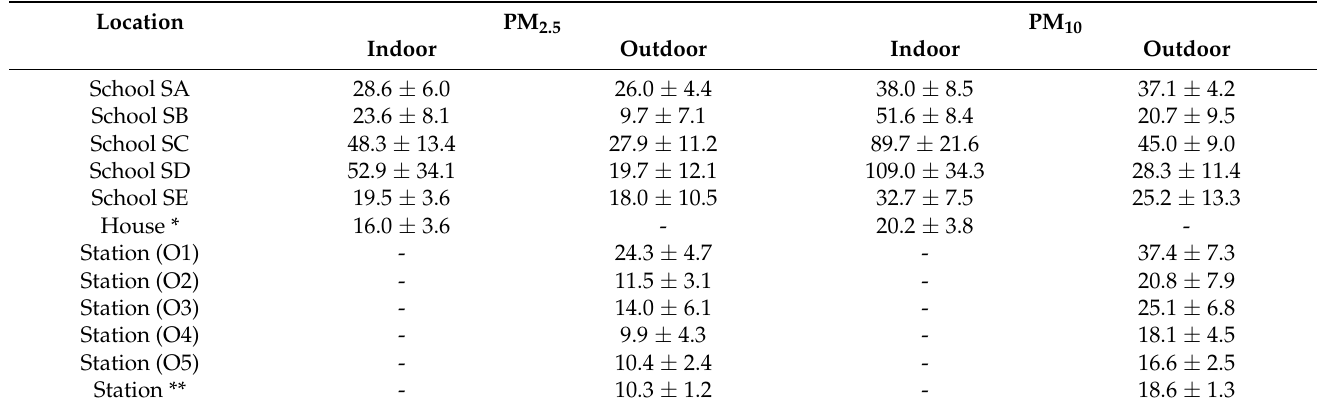
Table 2. Average ( ± standard deviation) of PM 10 and PM 2.5 concentrations ( µ g/m 3 ) measured in schools, houses, and Olivais air quality monitoring stations. The measuring period corresponds to 8 h at schools and 15 h at the houses. PM 2.5 PM 10